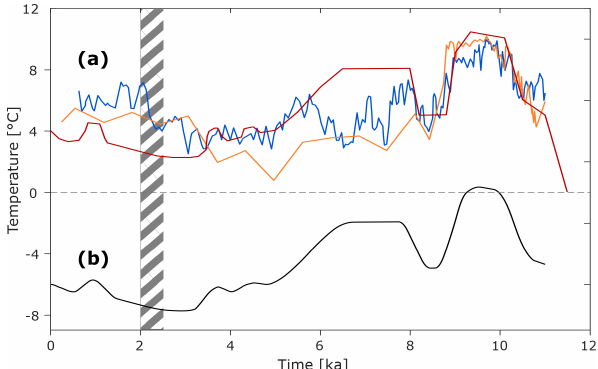
Figure 3. Holocene temperature reconstructions in and around Svalbard. Dashed grey area indicates time of minimal driftwood ar- rival (Farnsworth et al., 2020). The unit of the time axis is ka = 10 3 years before present. (a) MSST curves ( = MSAT, see text): red line from Mangerud and Svendsen (2017), orange line from Hald et al. (2007), and blue line from van der Bilt et al. (2018). (b) MAAT used in this work, based on Mangerud and Svendsen (2017) and Førland et al. (1997) (see Sect.